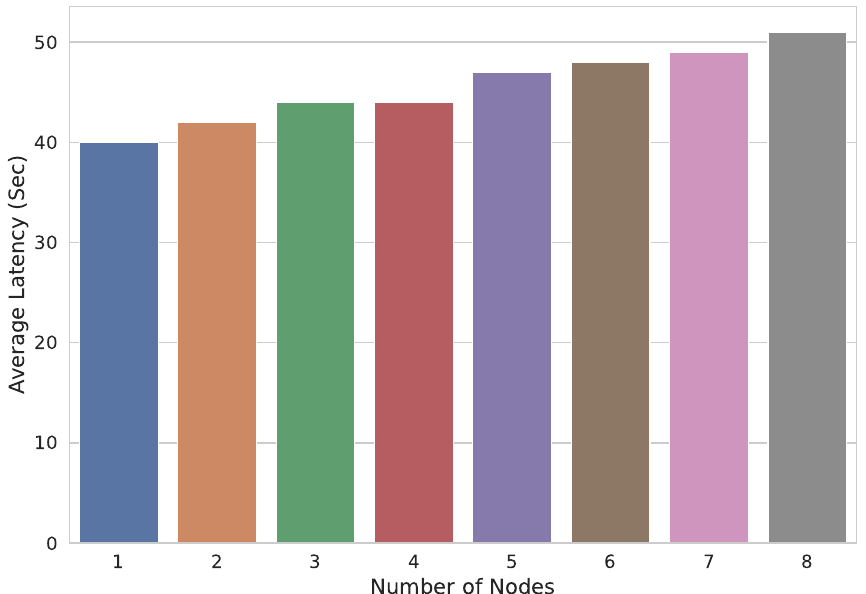
Figure 16. Transaction average latencies with varying number of